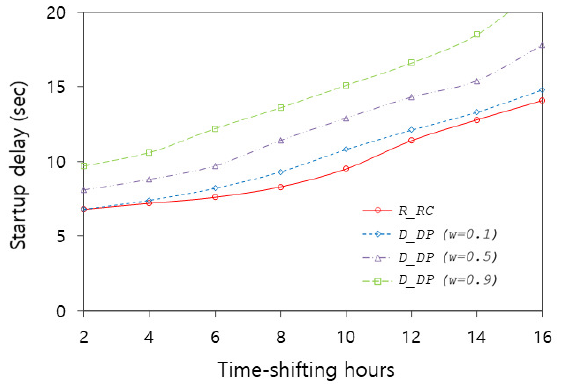
Figure 12. Comparison of startup delay between D _ DP and R _ RP in distribution 1 with 300 s buffer.